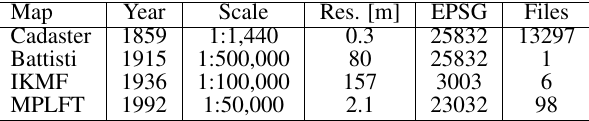
Table 1. Historical maps main features. The “Res.” column refers to ground resolution.